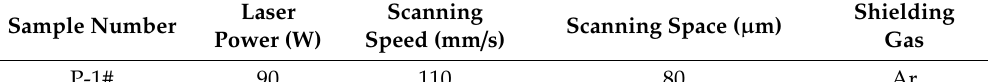
Table 2. Laser remelting process parameters.